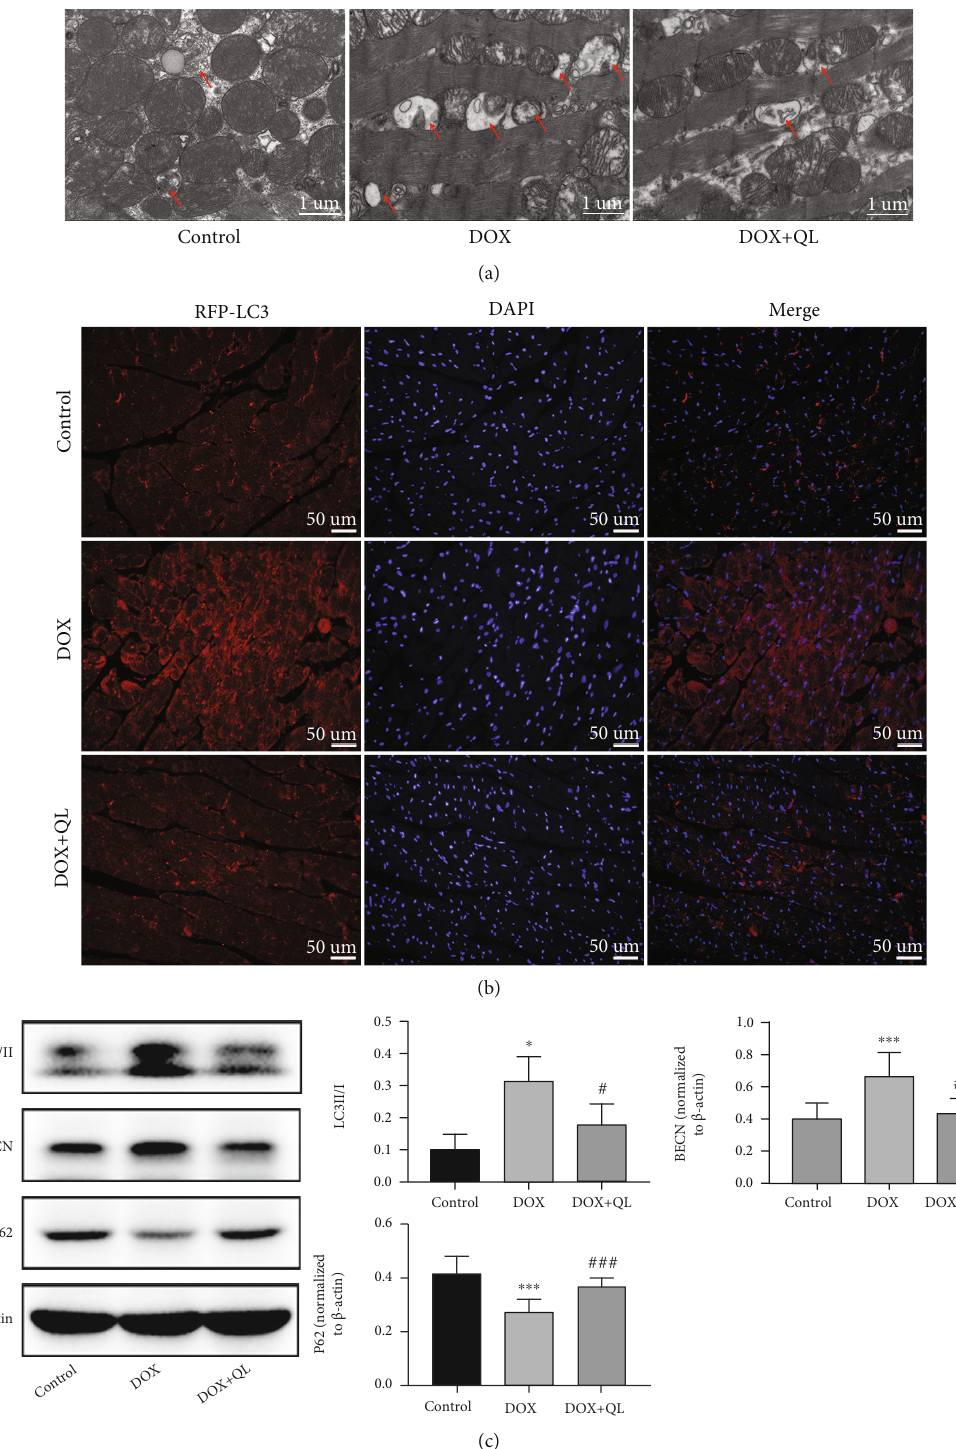
Figure 6: QL reduced DOX-induced excessive autophagy in rat hearts. (a) Representative electron microscopy images of heart tissues in di ff erent groups. The red arrows refer to autophagic vacuoles containing damaged organelles (300dpi, scale bar: 1 μ m). (b) Immuno fl uorescence images of LC3 II expression in di ff erent group heart tissues (300dpi, scale bar: 50 μ m). (c) The expression levels of autophagy-related molecules including LC3 I/II, BECN, and P62 in di ff erent group heart tissues by western blot ( n = 6 ) (values are presented as mean ± SD ; ∗ P < 0 : 05 and ∗∗∗ P < 0 : 001 vs. control group; # P < 0 : 05 , ## P < 0 : 01 , and ### P < 0 : 001 vs. DOX